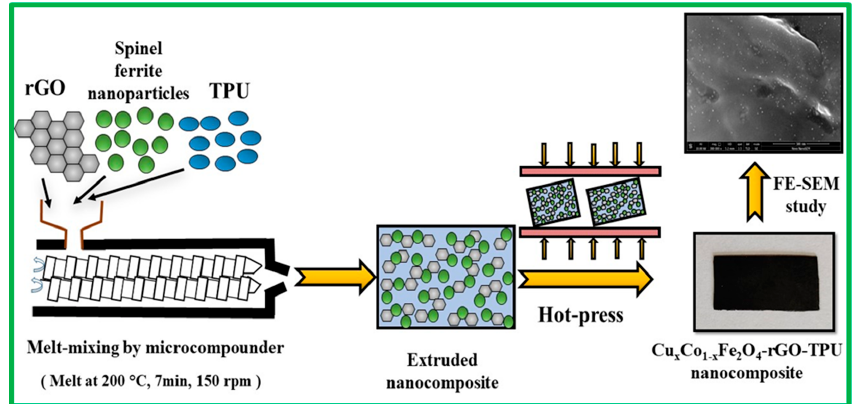
Figure 12. Schematic representation of the preparation of Cu x Co 1-x Fe 2 O 4 -rGO-TPU